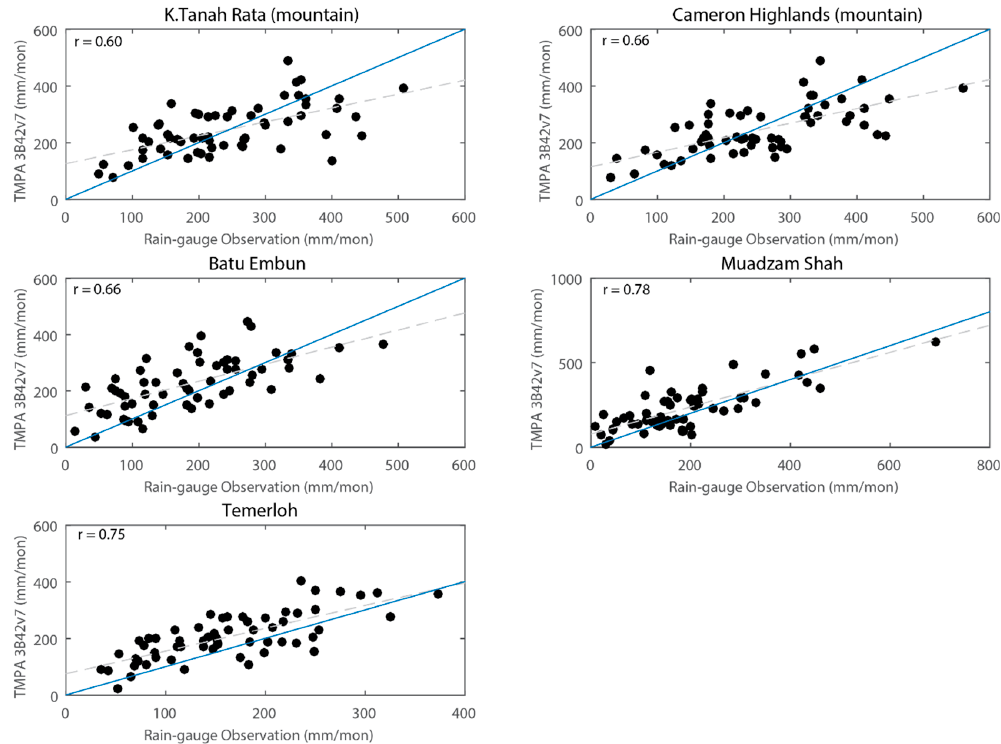
Figure 9. Scatter plot of TMPA 3B42v7 for five rain gauge locations in Middle Peninsular Malaysia (MPM).